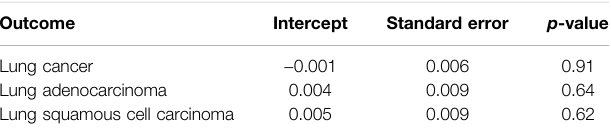
TABLE 4 | Results of MR Egger for the estimation of directional horizontal pleiotropy. Outcome Intercept